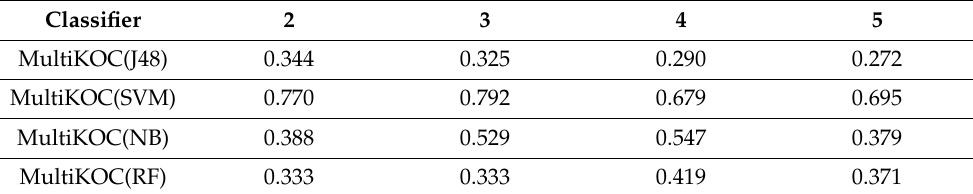
Table 8. Results summary for MultiKOC method with 2, 3, 4, 5 clusters on Iris-setosa-versicolor data.